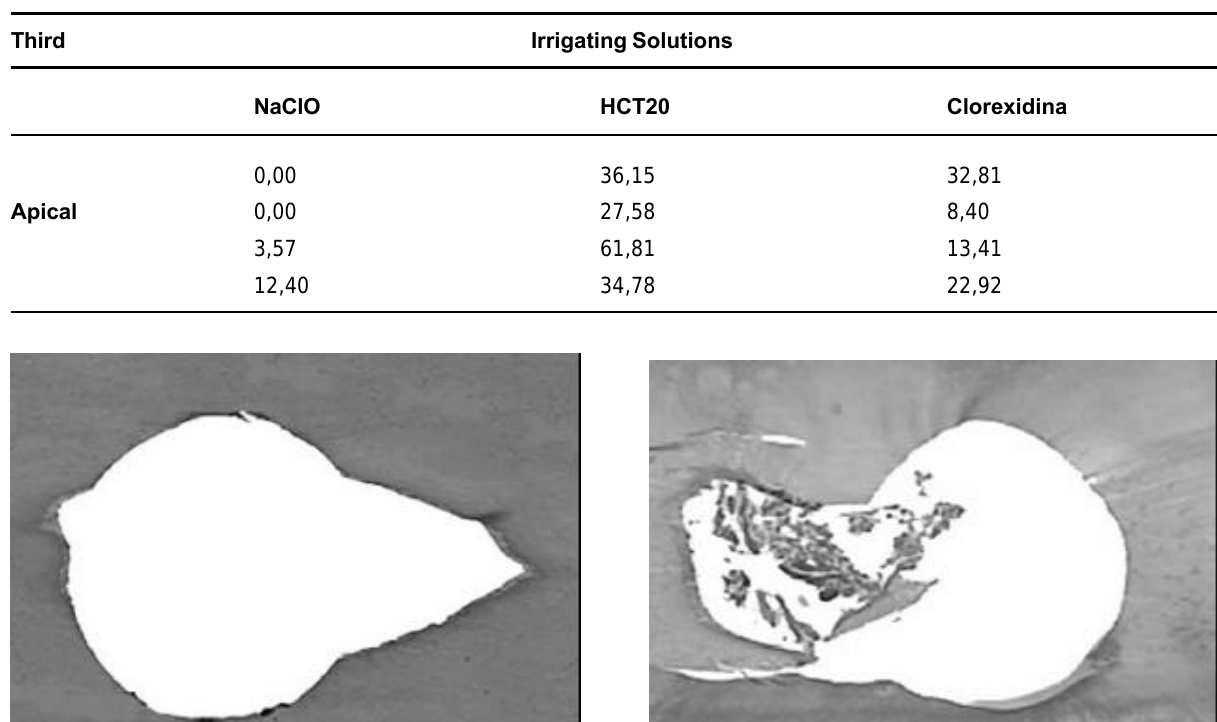
TABLE 1 . Percentage of transversal area of the root canal containing debris